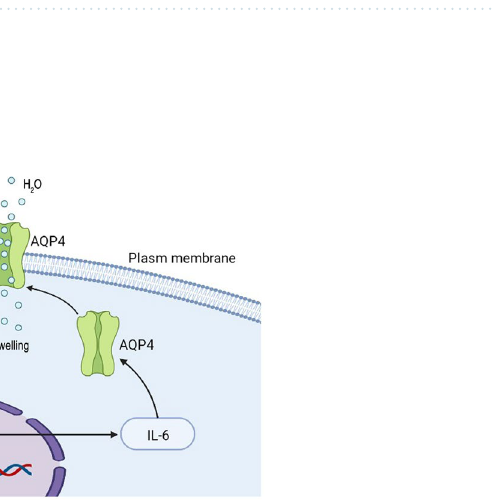
Figure 6. Schematic illustration of TSO IIA preventing AQP4 overexpression in PM and astrocyte swelling after OGD/R by inhibiting the HMGB1/RAGE/NF-κB/IL-6 pro-inflammatory